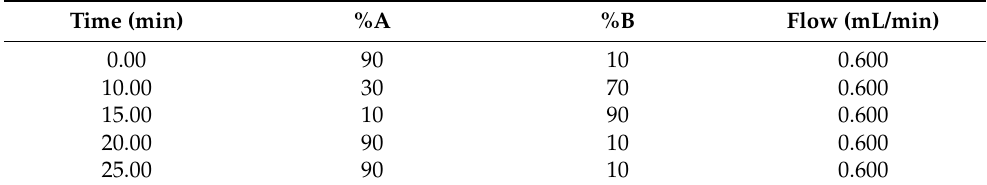
Table 1. LC gradient elution program, A: 0.1% formic acid solution in water, B: 0.1% formic acid solution in 95:5